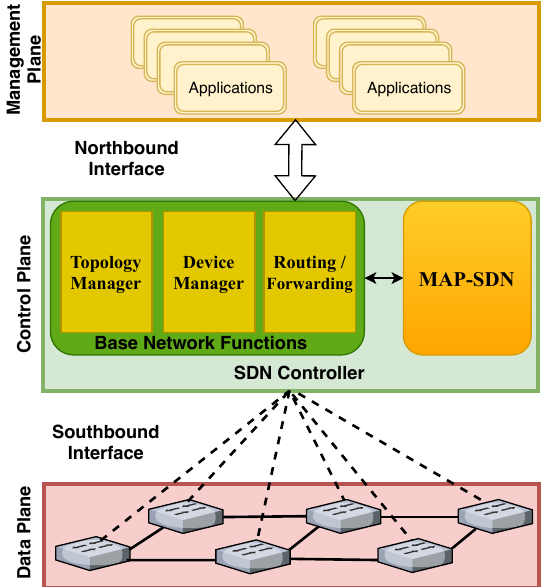
Figure 1. Layered view of SDN